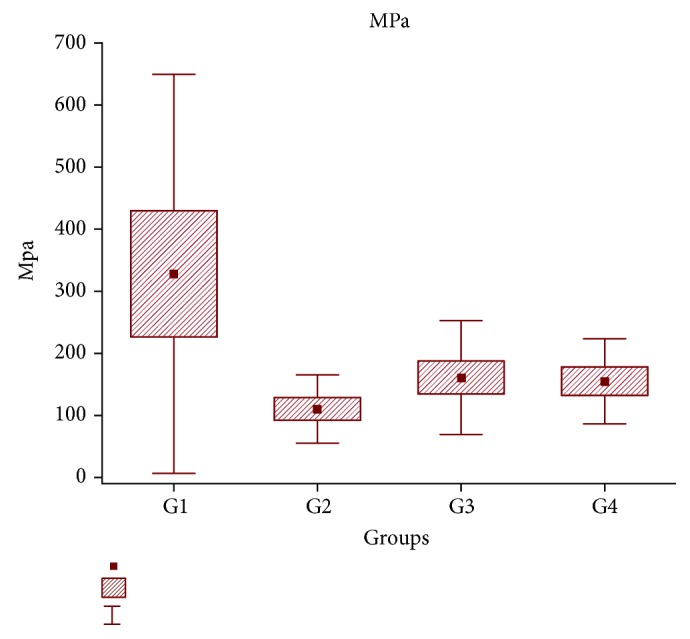
A histogram showing the elastic modulus, which is significantly lower in the PRP group and higher in the SC group. G1 = SC; G2 = PRP; G3 = SC+PRP; G4 = ET. MPa: elastic modulus; SC: stem cell; PRP: platelet-rich plasma; sd: standard deviation; se: standard error.